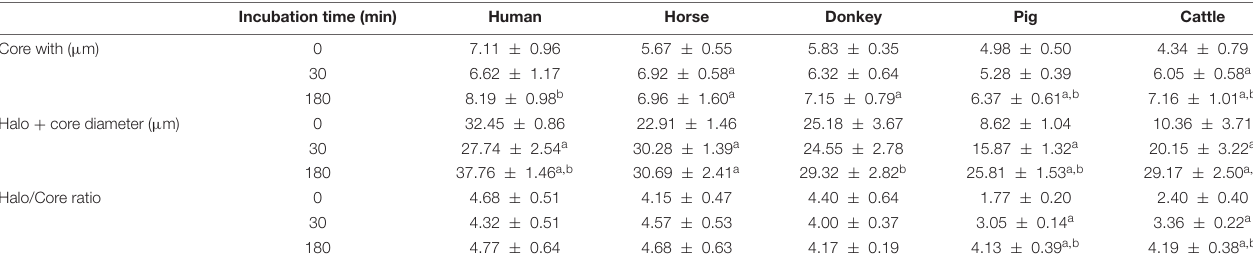
FIGURE 2 | Decondensation of sperm DNA through the formation of sperm haloes. It is worth noting that porcine and bovine sperm presented higher DNA decondensation with increasing incubation times over the third lysis step containing proteinase K. In contrast, no significant changes in human, horse and donkey sperm were observed. Scale bar: 5 µ m. TABLE 1 | Effect of the third lysis solution containing proteinase K on halo and core diameter in different species. Incubation time (min) Human Horse Donkey Pig